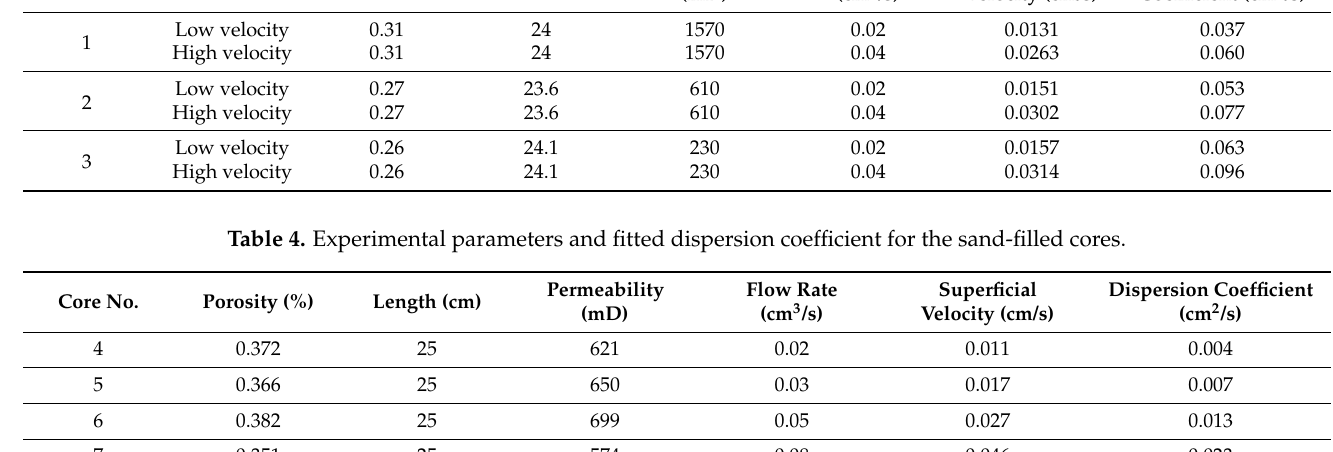
Figure 6. Data fitting for tracer concentration ratio versus pore volume injected (PVI) at different flow rates in sand-filled cores: ( a ) 0.02 cm 3 /s; ( b ) 0.03 cm 3 /s, ( c ) 0.05 cm 3 /s, and ( d ) 0.08 cm 3 /s. Table 3. Experimental parameters and fitted dispersion coefficient for the natural cores.